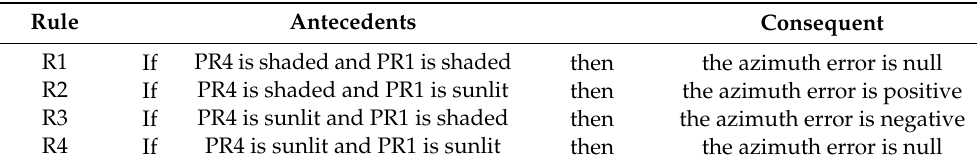
Table 4. Action rules for the azimuth error (PR3 and PR2).